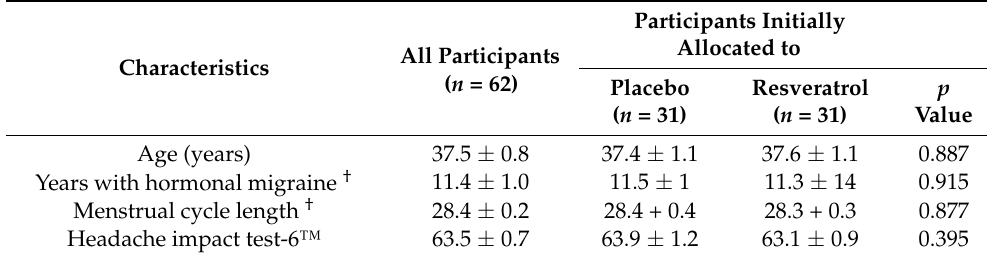
Table 1. Participant